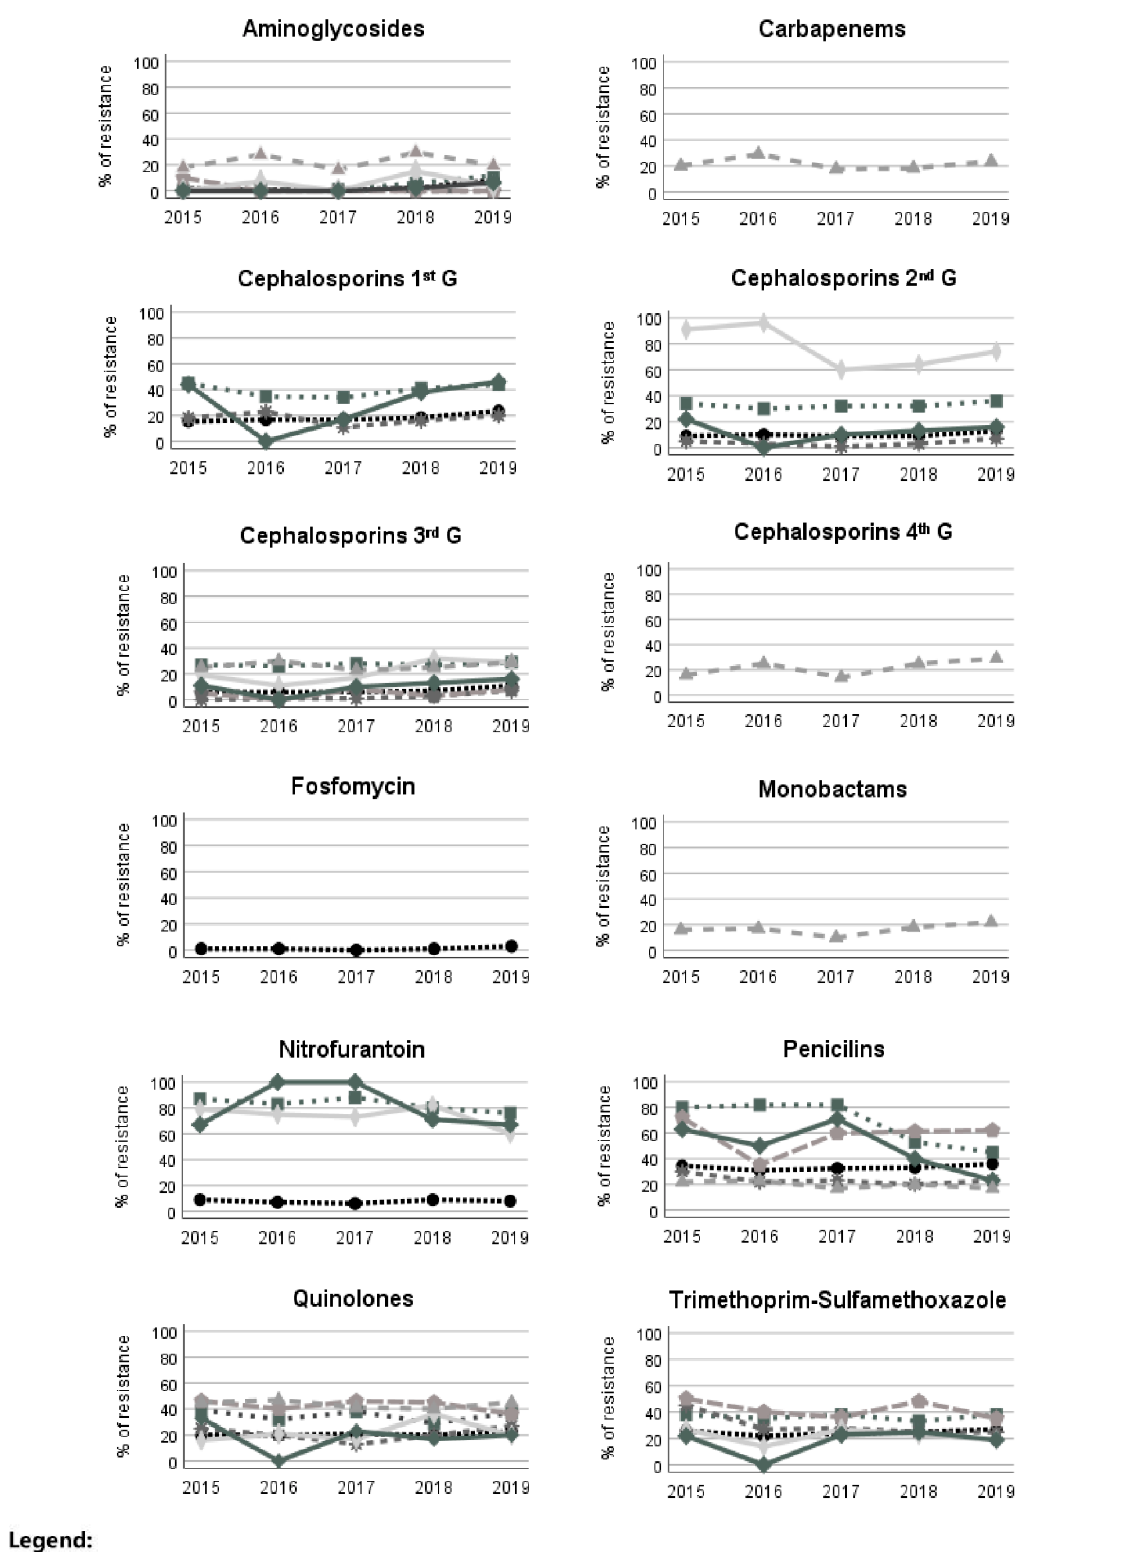
Figure 2. Variation in the antimicrobial resistance patterns of Gram-negative bacteria during the study period (2015–2019). G, generation.